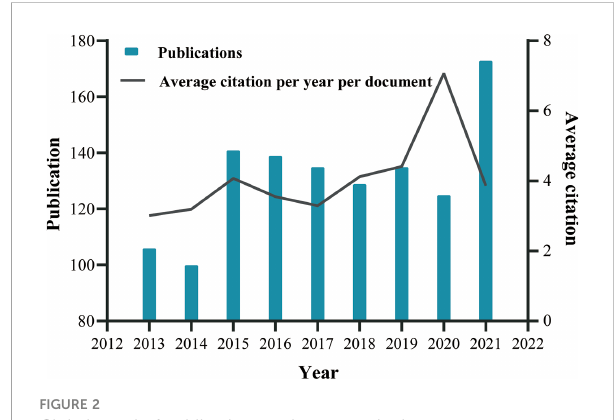
FIGURE 2 Global trend of publications and average citation per year per document on endoscopic application in ECG from 2013 to October 2021, performed by GraphPad Prism 8. For more accurate visualization, we omit the incomplete data for 2012 and